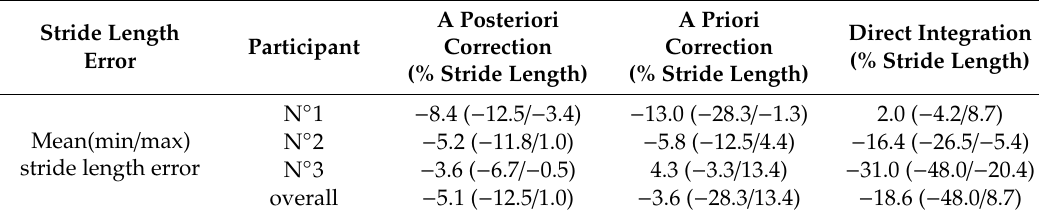
Table 5. Errors on the stride length estimation. Mean stride length error and % RMSE are computed using the estimation of the stride length of each gait